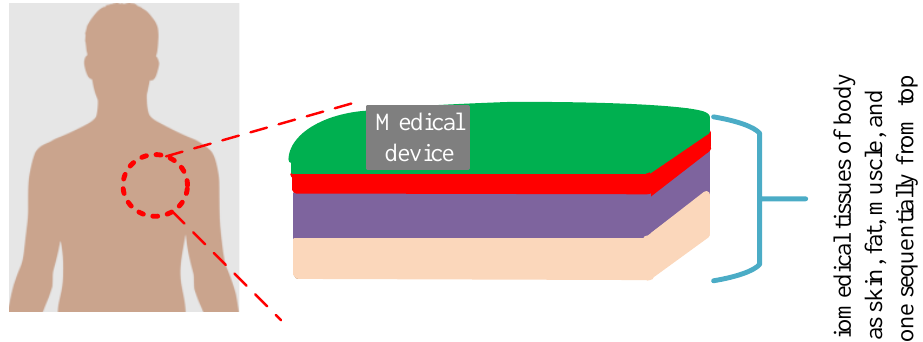
Figure 14. RFID that is used on the skin of humans.